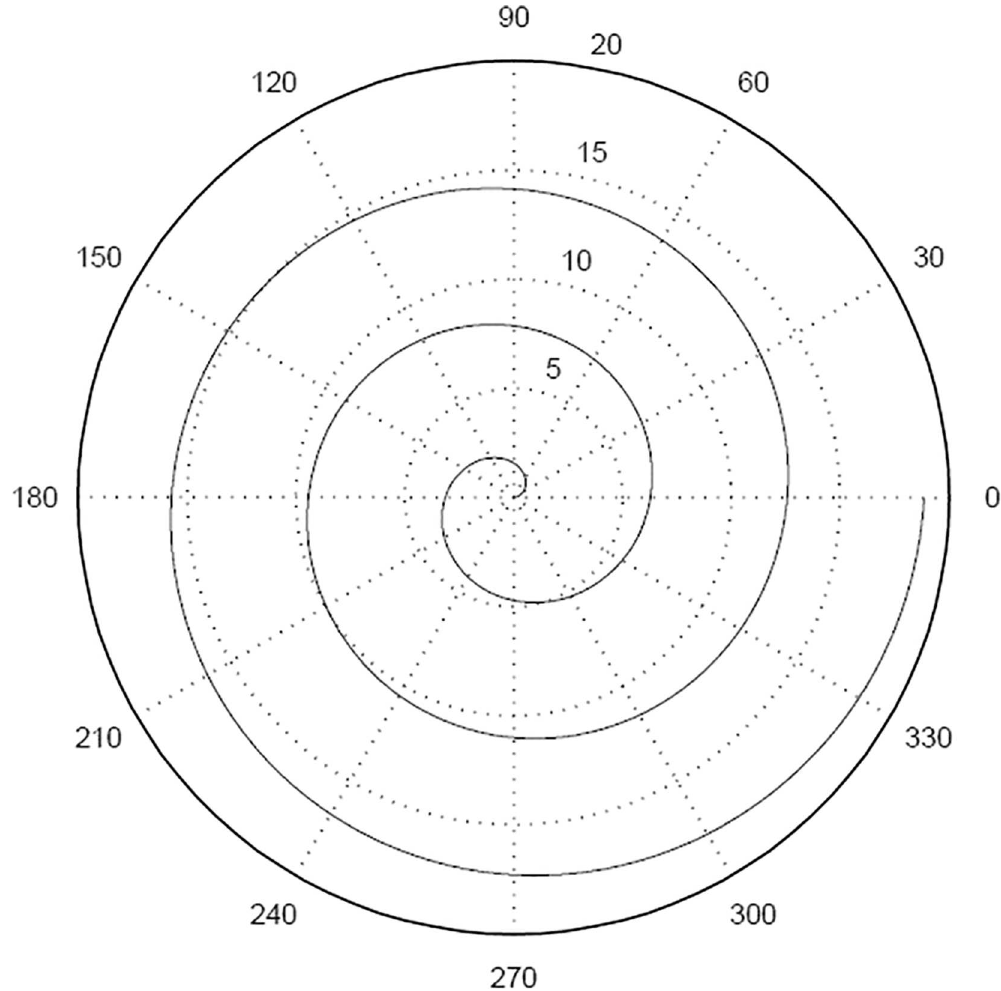
Fig 1. Archimedes